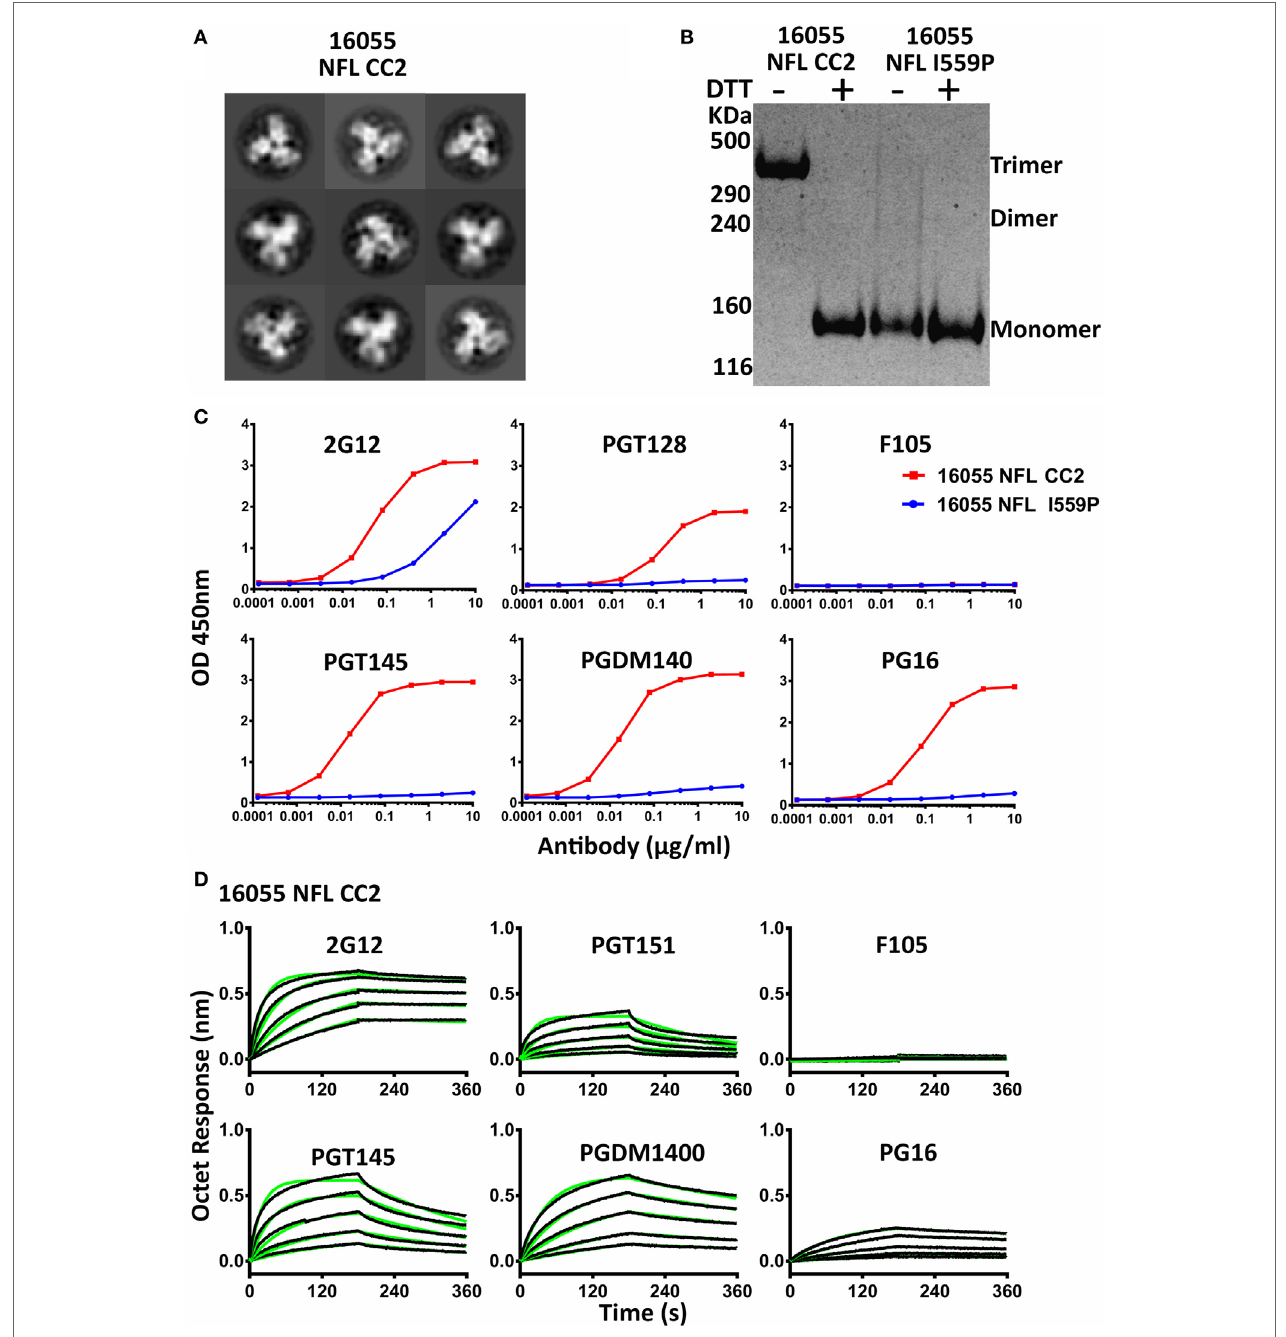
FigUre 3 | Biochemical, biophysical, and antigenic properties of 16055 NFL CC2 trimers. (a) 2D class averages from negative stain electron microscopy of 16055 NFL CC2 trimers. (B) Disulfide bond formation was determined by SDS-PAGE under reducing and non-reducing conditions, respectively. Under reducing conditions, all proteins displayed a gp140 species. Under non-reducing conditions, the CC2 proteins displayed a trimeric gp140 species, migrating more slowly in the gel. (c) ELISA binding of selected mAbs to the 16055 NFL CC2 trimers and the EC 50 values are summarized in Table 2 . (D) BLI measurements for 16055 NFL CC2 trimers with selected mAbs. The fitting curves are shown in green and the kinetic parameters are summarized in Table 3